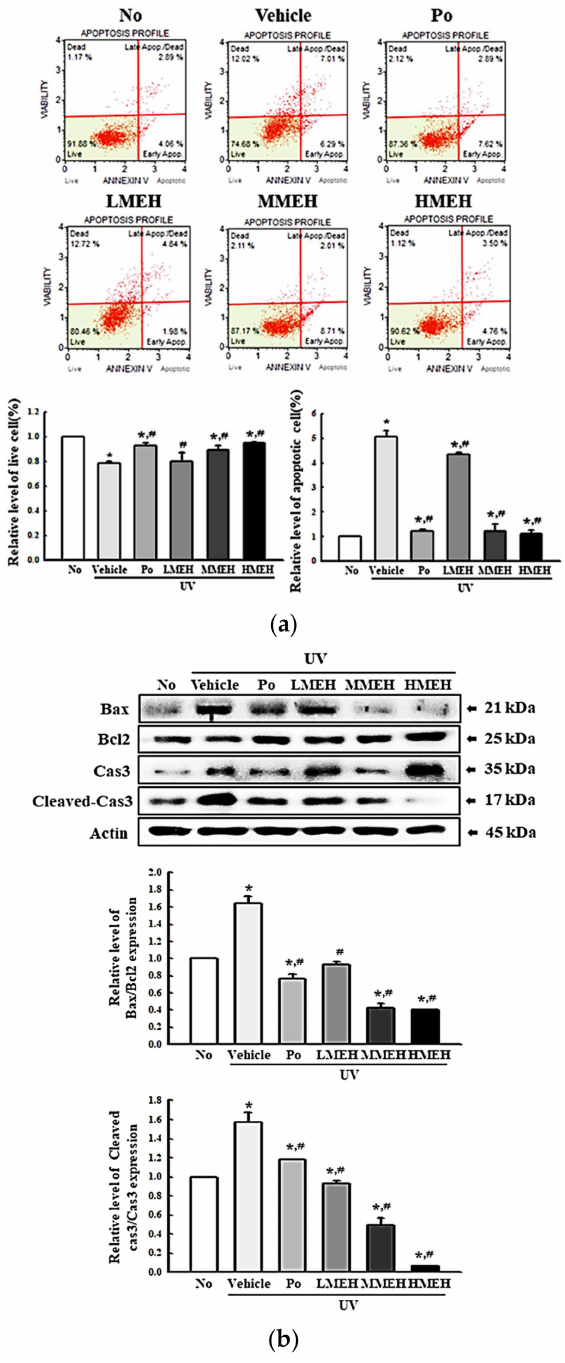
Figure 6. Apoptosis related parameters analysis in normal human dermal fibroblasts. ( a ) Determina- tion of live and apoptotic cells. Two to three wells per group were used for Annexin V and 7-AAD staining. The population analysis was performed in triplicate and the assay was repeated for three times; ( b ) Expression levels of apoptotic proteins. Bands for four apoptotic proteins including Bax, Bcl2, Cas-3 and Cleaved Cas-3 on the membrane were detected with the specific antibodies and quantified using an imaging densitometer. Three dishes per group were used to prepare the cell lysates. Western blot analysis was performed in triplicate and repeated for three times. The data are reported as the mean ± SD of triplicates determination. *, p < 0.05 compared to the untreated group. #, p < 0.05 compared to the UV + Vehicle group. Abbreviations: 7-AAD, 7-Aminoactinomycin D; Cas-3, Caspase 3; Bax, Bcl2-associated X protein; Bcl2, B-cell lymphoma 2; Po, Positive control; MEH, Methanol extract of Hygrophila erecta (Brum. F.) Hochr; IgG, Immunoglobulin